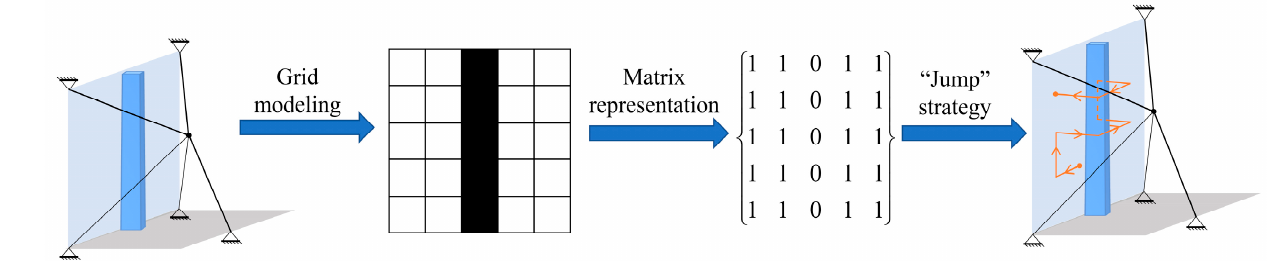
Figure 5. Application scenario of the jump obstacle-crossing mode.